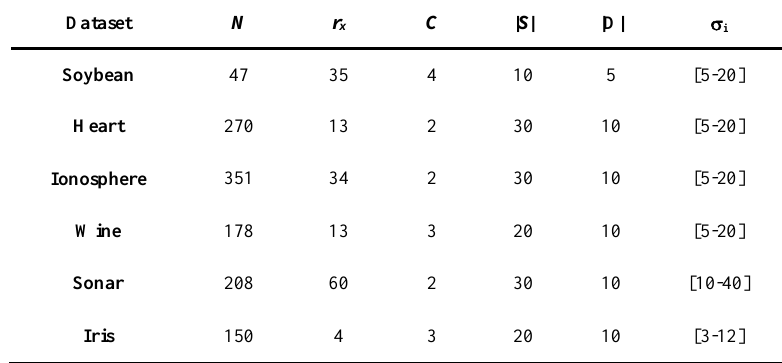
Table 2. Main characteristics of UCI datasets and associated experimental